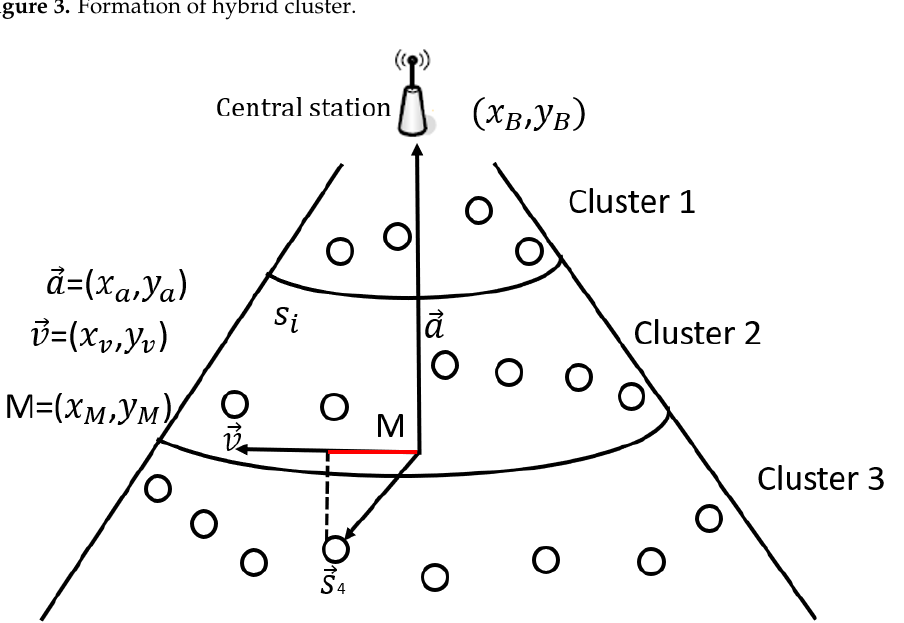
Figure 4. The method of projection for chain